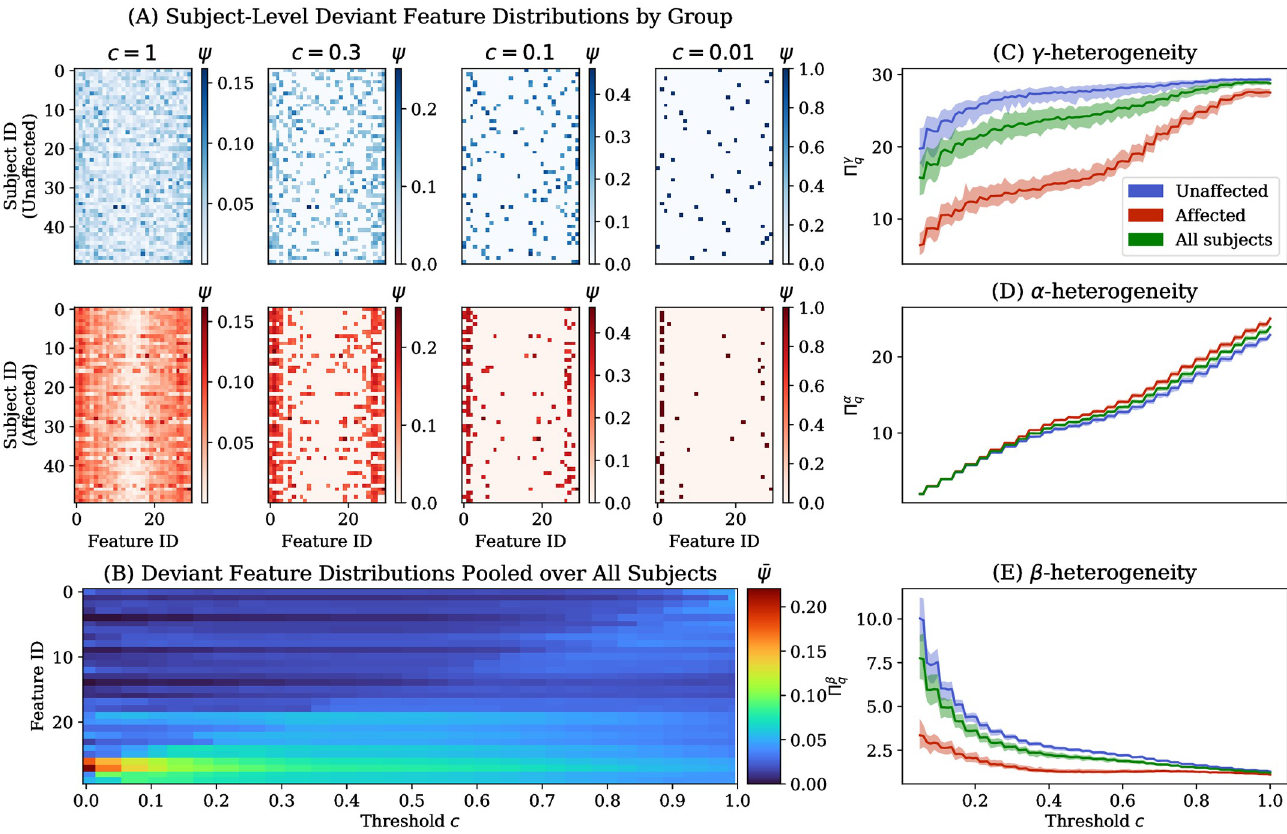
Fig 3. Measurement of heterogeneity in the synthetic clinical cohort. Panel A : Subject-level probability distributions over the most c -deviant (i.e. top 100c%) features. Each row within a heatmap is a probability distribution computed using Eq 4, and columns show distributions across thresholds c 2 {0.01, 0.1, 0.3, 1}. Panel B : Pooled distribution over c -deviant features ( � c ð Z � ; c Þ ; Eq 8), shown column-wise, across values of c (on x-axis). Panels C-E : The γ (Eq 7), α (Eq 9), and β heterogeneity (Eq 10), respectively, in the unaffected (blue), affected (red), and pooled (green) cohorts. Solid lines are means, and shaded ribbons are 95% confidence